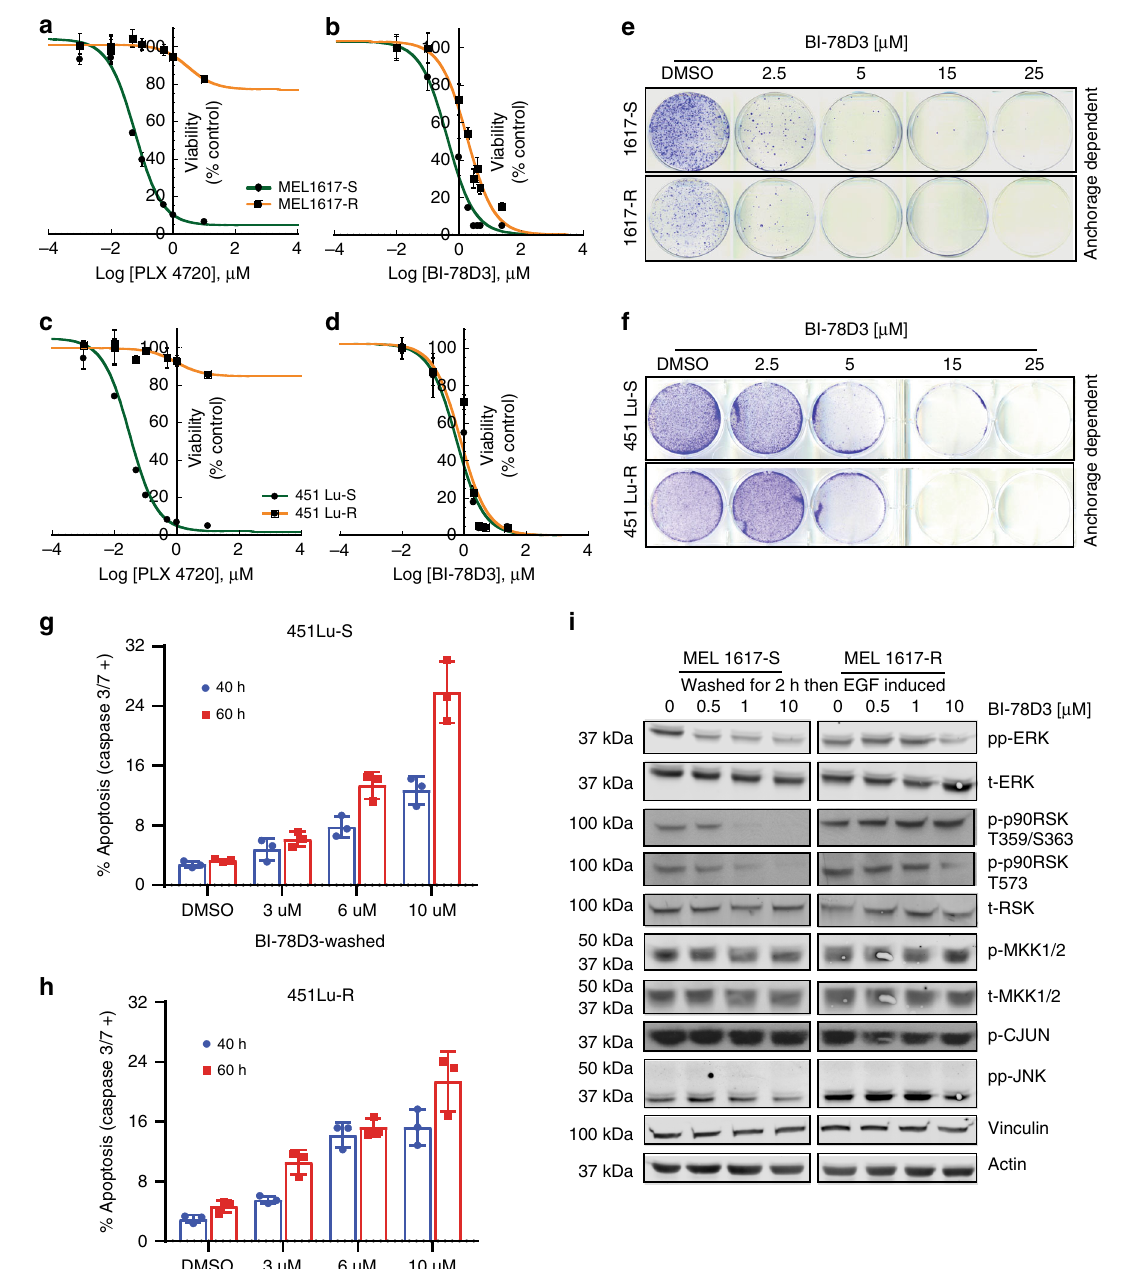
Fig. 6 BI-78D3 overcomes acquired resistance to BRAF inhibition in melanoma cell lines. a – d BI-78D3 is equally potent in PLX4032-sensitive (-S) or -resistant (-R), BRAF- mutant melanoma cell lines. Cells were treated with either PLX4032 or BI-78D3 as shown and incubated for 72 h before analysis using an MTS assay (Error bars: ±SD ( n = 3)). e , f BI-78D3 inhibits the anchorage-dependent growth of PLX4032-sensitive and -resistant melanoma cell lines (experiments were repeated at least two times). g , h BI-78D3 induces caspase-3/7 activity in 451 Lu-S and 451 Lu-R cell lines. Cells were analyzed using an IncuCyte caspase-3/7 reagent and the IncuCyte ® ZOOM at the indicated time points. (IncuCyte imaging. Error bars: SEM ( n = 3)). i Western blot analysis to evaluate the suppression of EGF-stimulated cell signaling in melanoma cell lines by BI-78D3. Cells were serum starved overnight then treated with BI-78D3 for 1 h in serum-free media, followed by inhibitor washout for 2 h in the same media. Cells were then stimulated with EGF for 30 min in full media. Images have been cropped for presentation; the uncropped images are shown in Supplementary Fig.